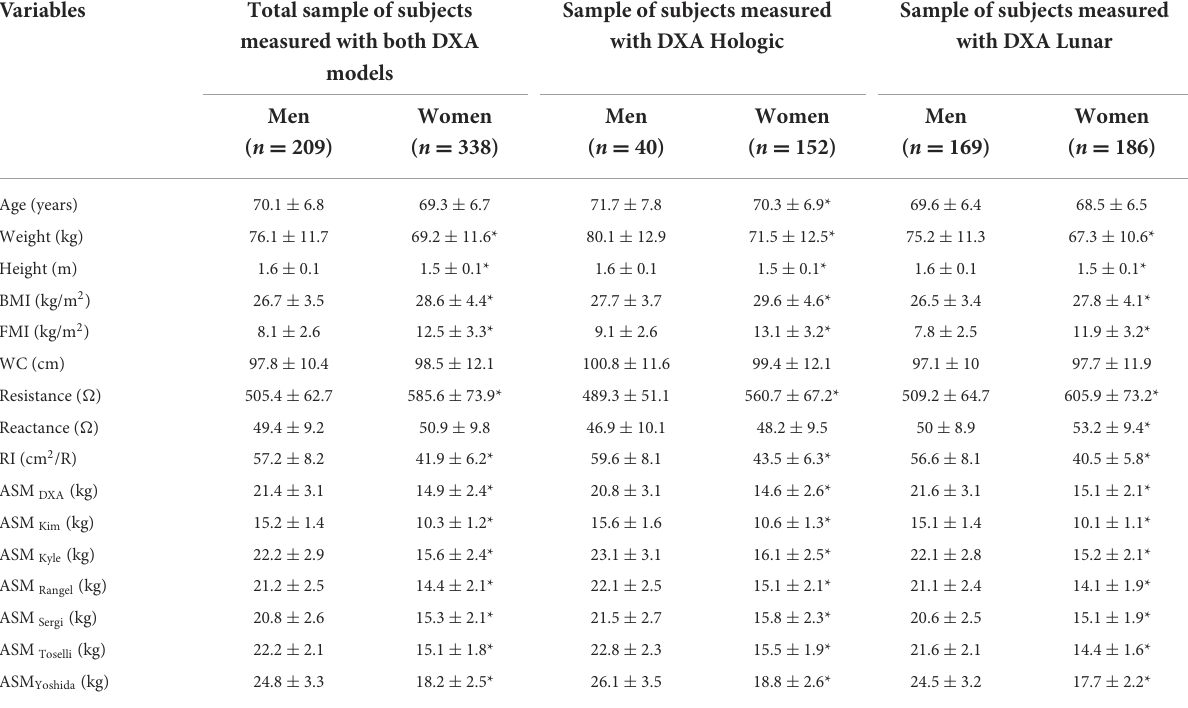
TABLE 1 General characteristics of the